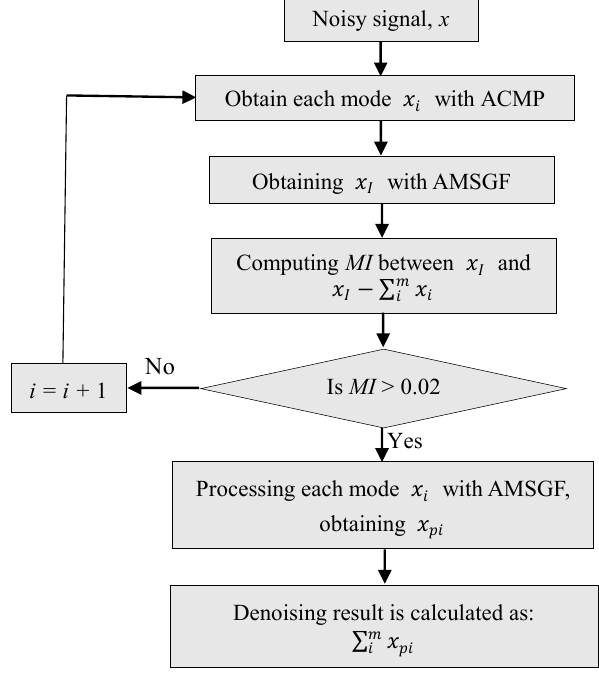
Figure 4. Flow chart for the proposed algorithm.